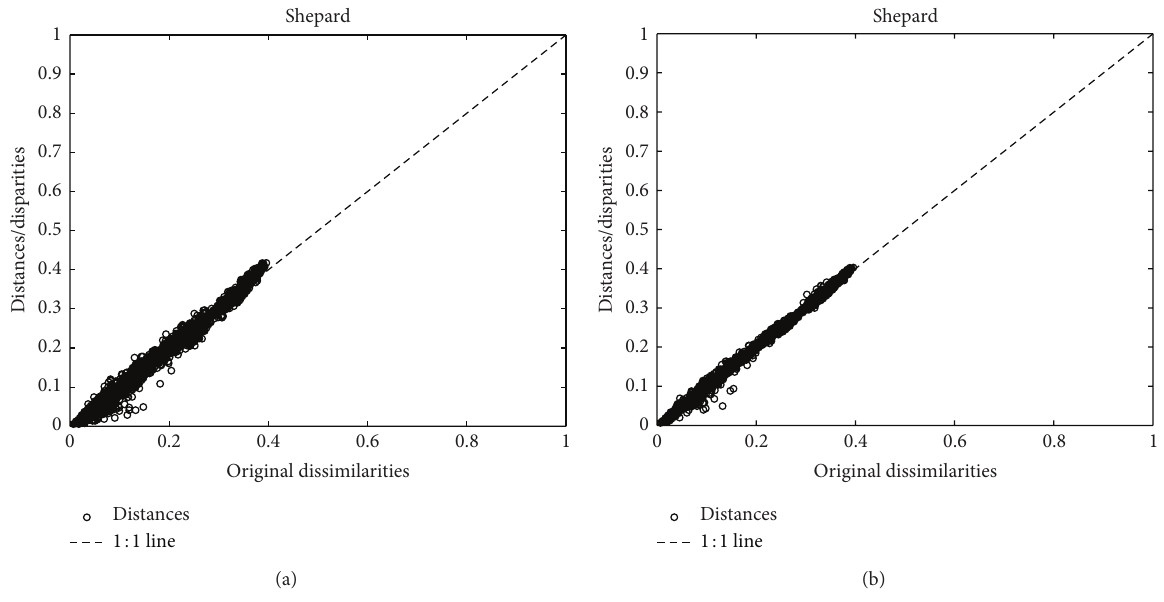
Figure 5: Shepard diagrams of the MDS representation of the Portuguese economic evolution, with 𝑟 𝐶 , 𝑇 = 1865 – 2010 , and ℎ = 2 years for the 2d and 3d maps.